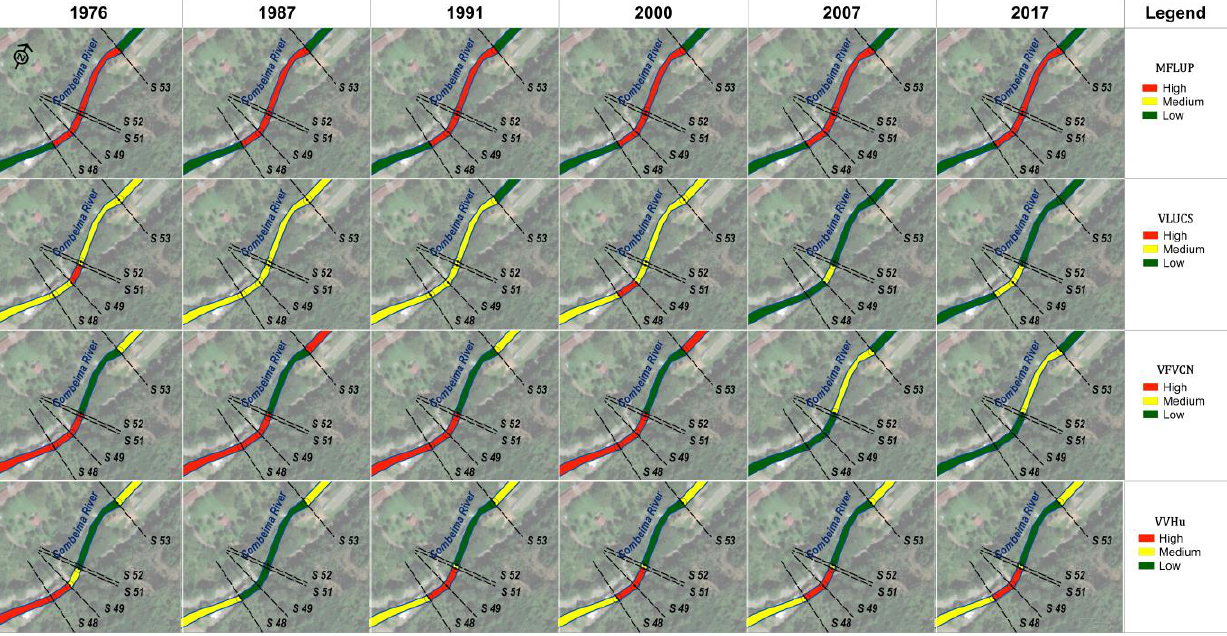
Figure 6. Changes in physical vulnerability in the 1976–2017 period applying the four methods analyzed. MFLUP: vulnerability and mapping of floods based on land-use patterns; VLUCS: vulnera- bility in land-use change scenarios; VFVCN: vulnerability based on flow velocity and curve number; VVHu vulnerability based on soil water storage variation.